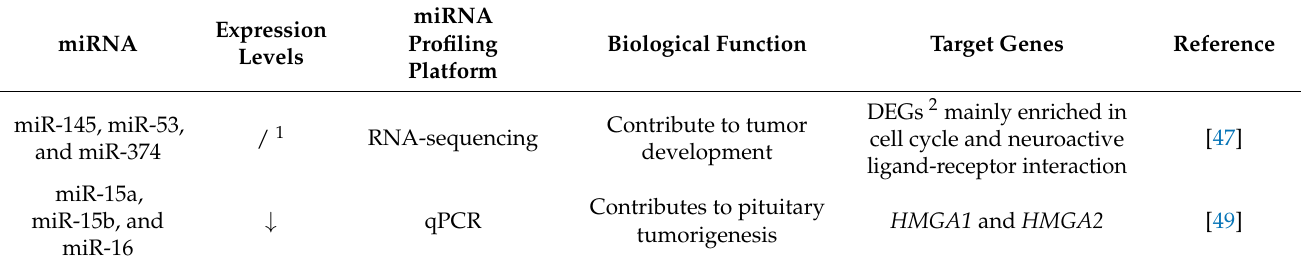
Table 2. Summary of differentially expressed miRNAs with their validated targets in gonadotrophinomas.